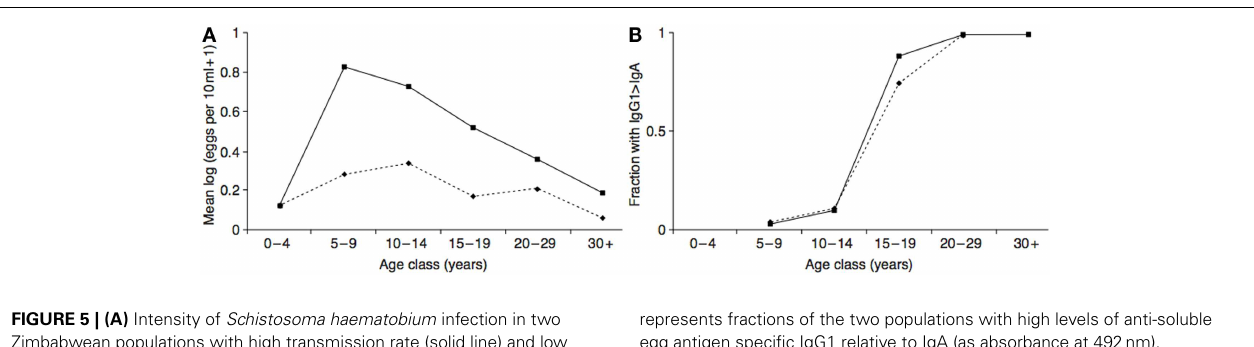
FIGURE 5 | (A) Intensity of Schistosoma haematobium infection in two Zimbabwean populations with high transmission rate (solid line) and low transmission rate (dashed line). (B) The resulting antibody switch.The y-axis